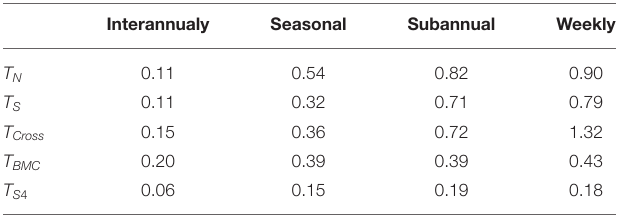
TABLE 2 | Standard deviation of transport (Sv) through selected sections, estimated over the entire model period (1993–2018).